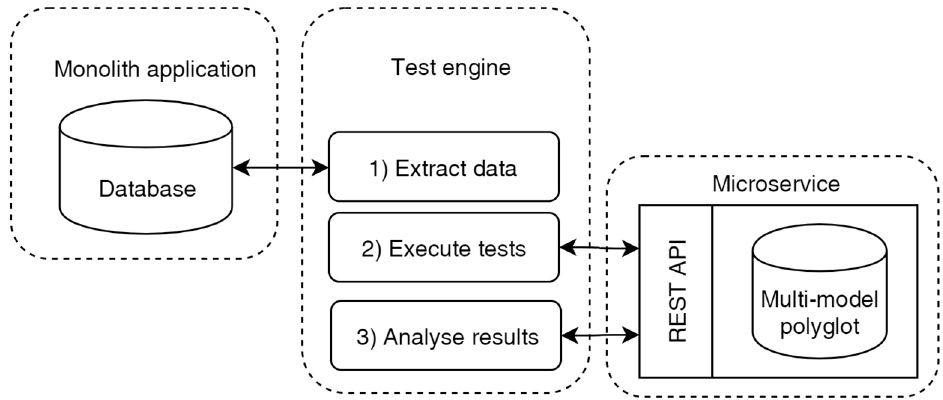
Figure 21. The automatic data validation process.